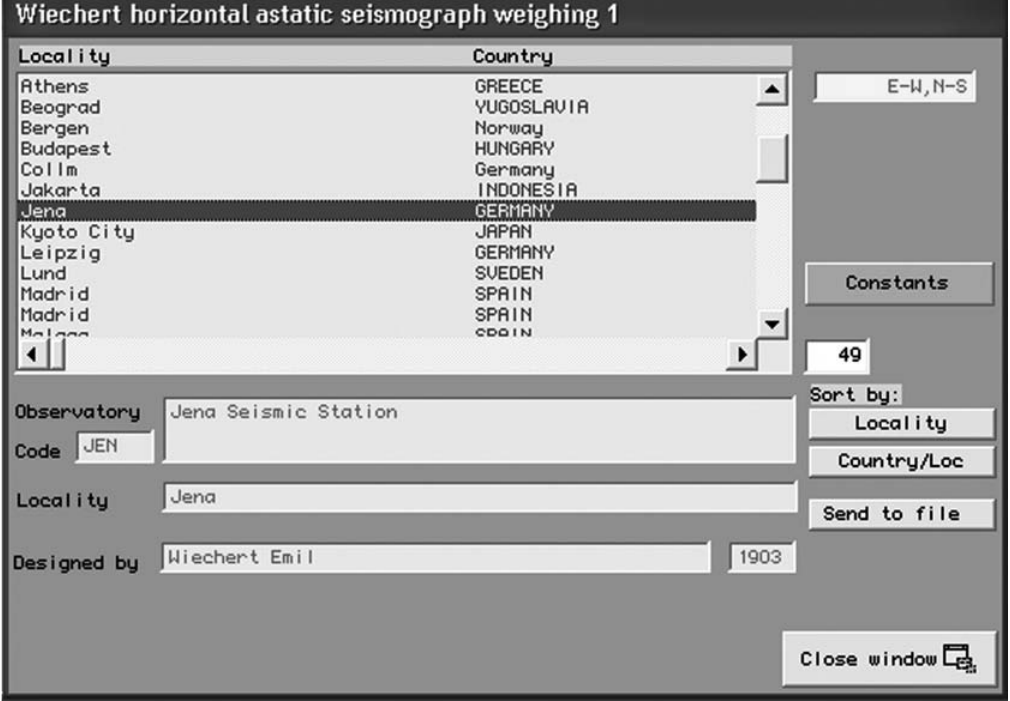
Fig. 6. Instruments file, example of record relating to the dissemination of the 1,000 kg Wiechert astatic horizon- tal seismograph. By double-clicking on a line of the list you can access the detail of the information on that specif- ic instrument. Highlighting a record from the list of bulletins it is enough to press the button Constants to access the window Instrument constants, which allows the visualisation of all the characteristics of the selected instrument and that in turn allows for the access to the consultation window of the constant history of the instrument (fig.